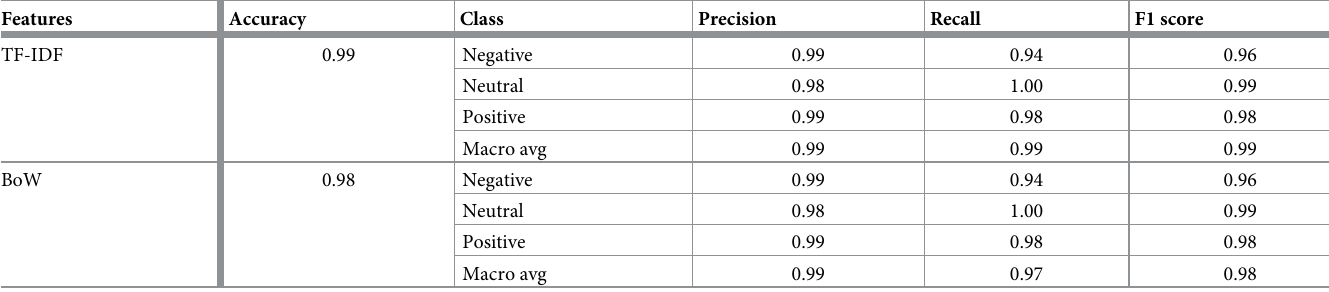
Table 7. Experimental results of the proposed EB-DT with TF-IDF and BoW features.